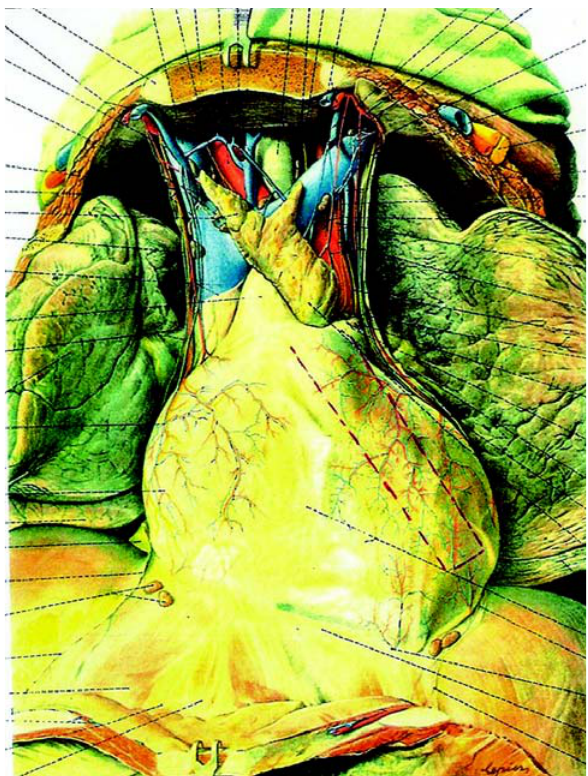
Fig. 1 – Ramos arteriais abundantes que vascularizam o pericárdio, vasos contíguos aos nervos frênicos. Orientação do retalho pericárdico, com sua base mais larga. As incisões para as bordas do retalho pediculado são feitas por baixo dos troncos arteriais, para não